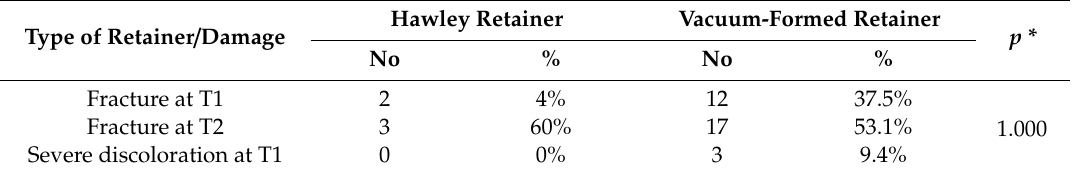
Table 4. Distribution of the patients according to the type of damage and type of retainer.